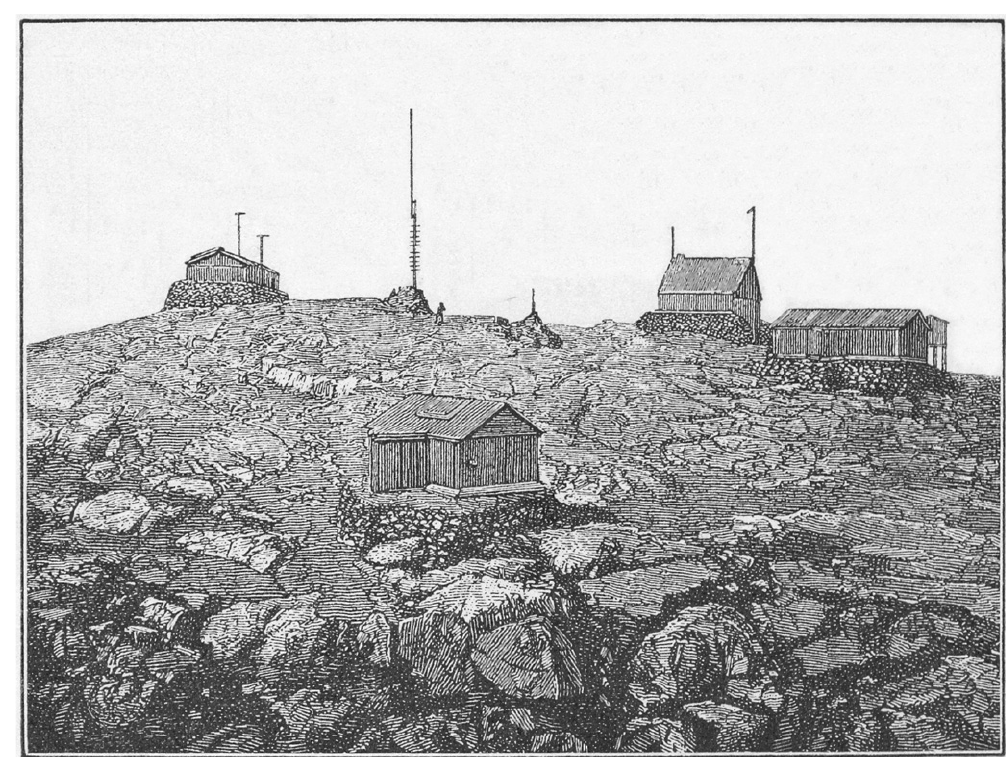
Figure 11. Polar Year Observatory in Godthaab (1882–1883) (drawing, Paulsen, 1893). aldrig nogensinde har bemærket nogen Lyd forbundet med Nordlyset, uagtet min Hørelse i Almindelighed har været ret god.”